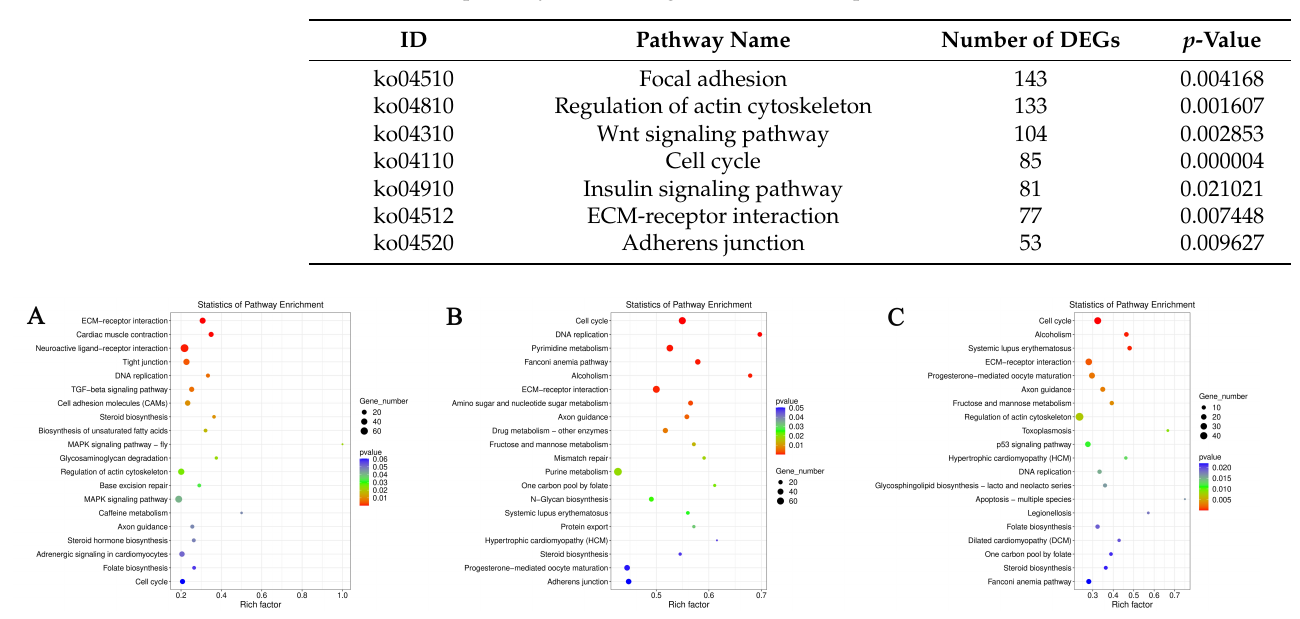
Table 4. KEGG pathways related to growth and development of breast muscle.